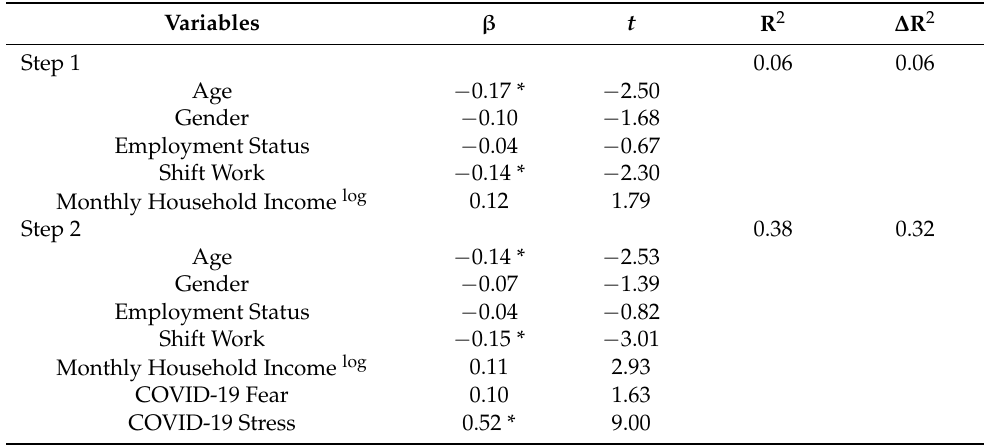
Table 2. Summary of hierarchical multiple regressions predicting anxiety from sociodemographic and occupational variables.